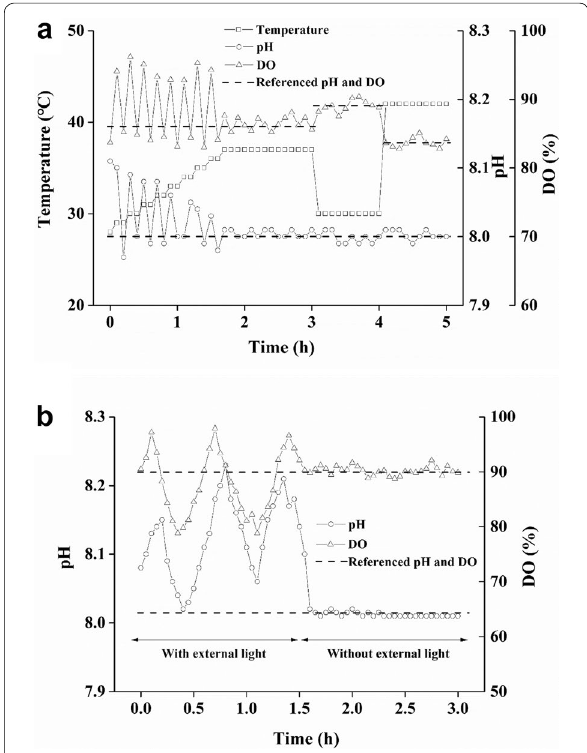
Fig. 3 Effects of environmental temperature ( a ) and external lighting ( b ) on the optical pH and DO